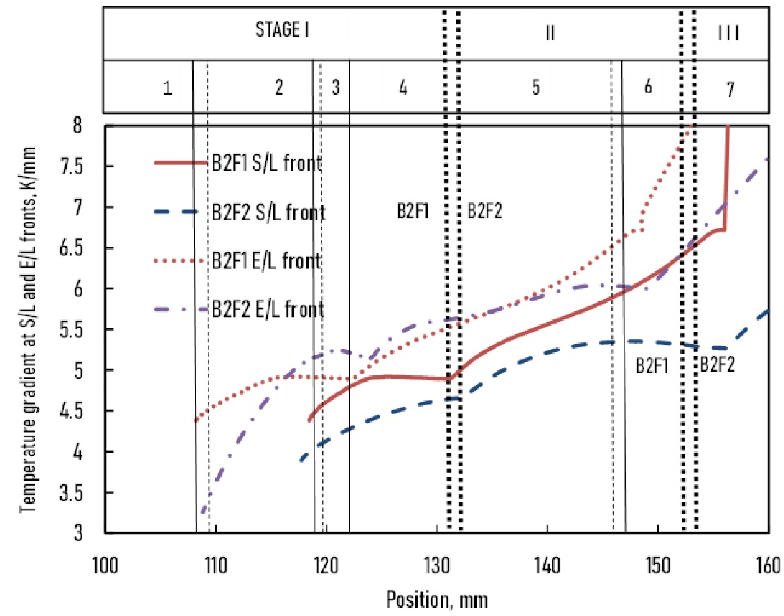
Figure 5. The temperature gradient vs. position of B2F1 and B2F2 samples. For B2F5 and B2F6 samples (Figure 6), the G L (x s ) and G E (x s ) functions evolved in parallel and decreased from the bottom to the top of the samples. The temperature gradi- ent was slightly higher in the B2F6 sample than in the B2F5 sample in stage I. When the magnetic induction was switched on, the difference was reversed, most likely because of the melt flow that developed. The difference between the G L (x s ) and G E (x s ) in stage I was small but increased to about 0.5 K/mm in stage II. Figure 6. The temperature gradient vs. position of B2F5 and B2F6 samples. 3.2. Analysis of the Microstructure The primary dendrites and the grain structure of the samples were analyzed in detail in [23–26]. In this work, the amount of eutectic and secondary arm spacing were analyzed as a function of the processing parameters of the experiments.